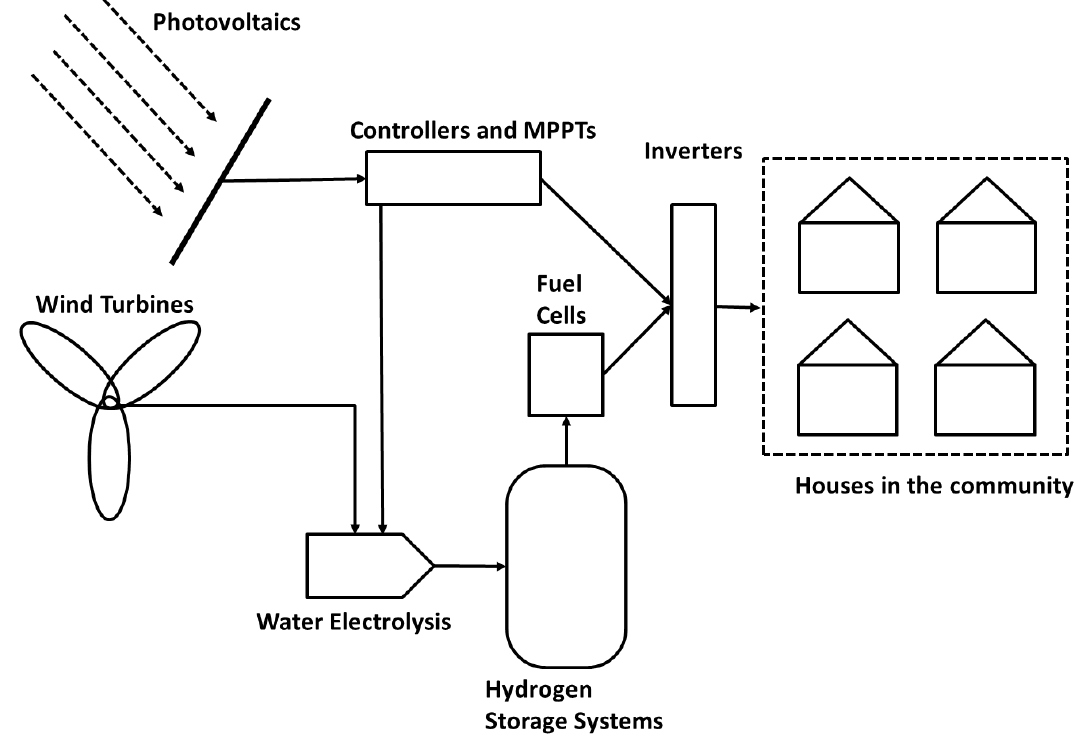
Figure 2. Schematic diagram of the housing community. Solar and wind energy with hydrogen energy storage meet the electric power demand.